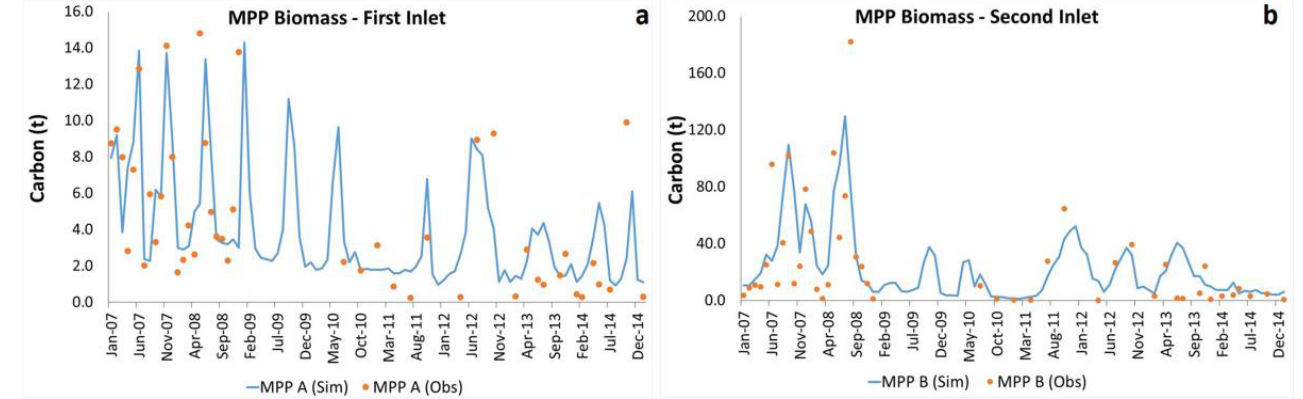
Figure 4. Micro-Phytoplankton (MPP) biomass (t of Carbon) simulated (line) and field data (dots) in the First Inlet ( a ) and in the Second Inlet ( b ) of Mar Piccolo. NPP biomass (on average up 31.7% of TPB) was characterized by slight temporal varia- tions and a peak due to cryptophyceans was detected in December 2007 (SI, 306.7 µ g C L − 1 ) (Figure